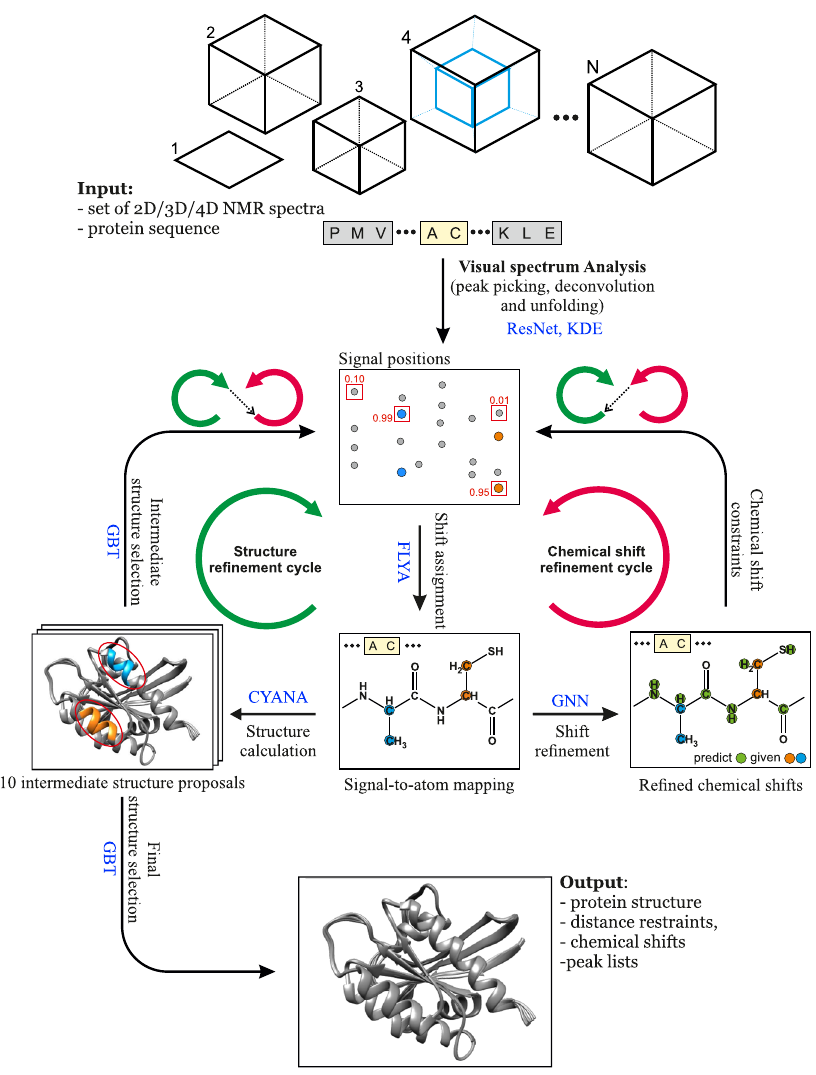
Fig. 1 | The ARTINA work fl ow for automated NMR protein structure determi- nation. The fl owchartpresents the interplay between the main componentsof the automated protein structure determination work fl ow: Residual Neural Network